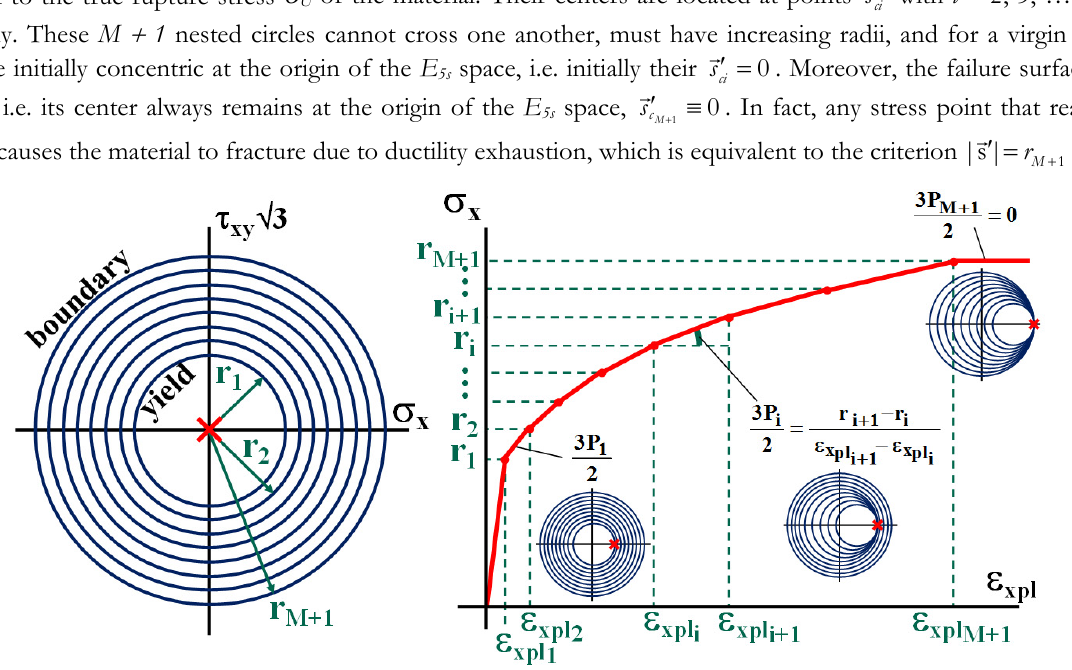
Figure 1: Yield, hardening and failure surfaces in the  x   xy  3 2D sub-space of E 5s (left) and corresponding radii r i and generalized plastic moduli P i obtained from the piecewise linearization of the uniaxial stress versus plastic strain curve